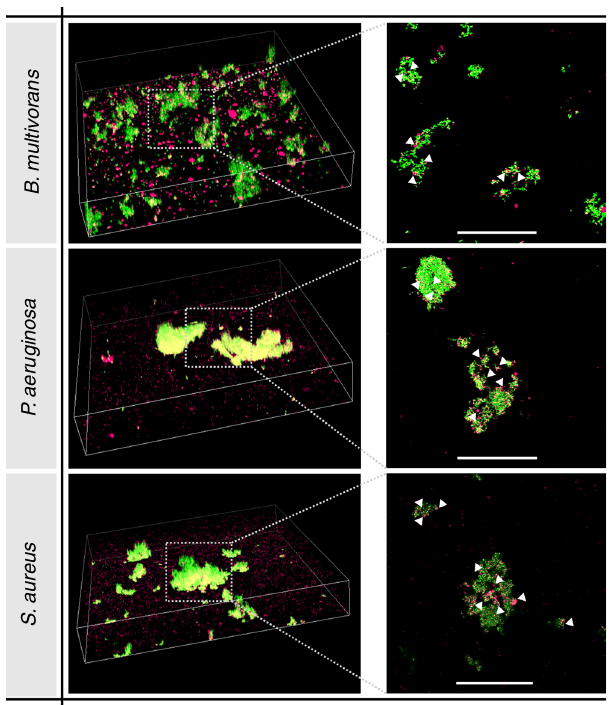
Fig. 3 AuNP penetration through bio fi lms. Confocal images of AuNP (magenta) in bio fi lms of B. multivorans , P. aeruginosa , and S. aureus (green). Left: Large-view 3-D confocal images showing various cell clusters. Width = 212 µ m, height = 212 µ m, depth = 35 µ m ( B. multivorans, P. aeruginosa ), 30 µ m ( S. aureus ). Right: Magni fi ed view of the middle plane of selected cell clusters showing the presence of AuNP (some examples are indicated with white arrowheads) throughout the clusters. Scale bar = 50 µ